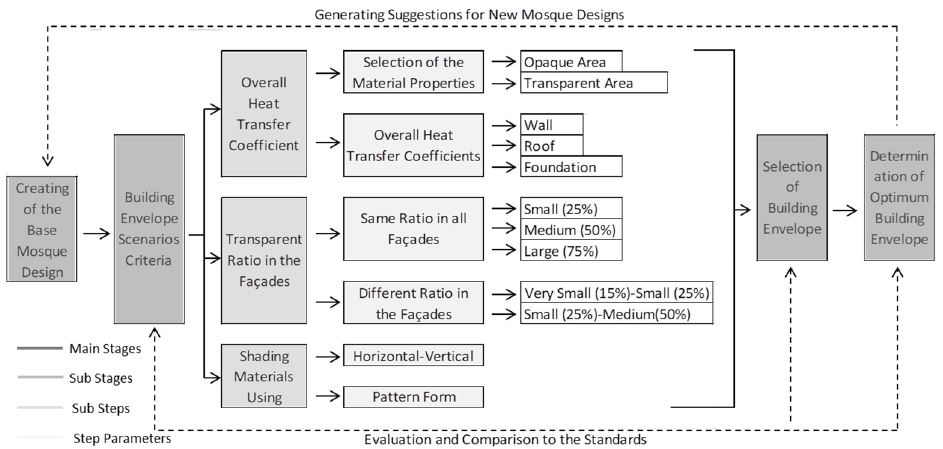
Figure 1. Stages of determining the optimum envelope properties of the mosques.